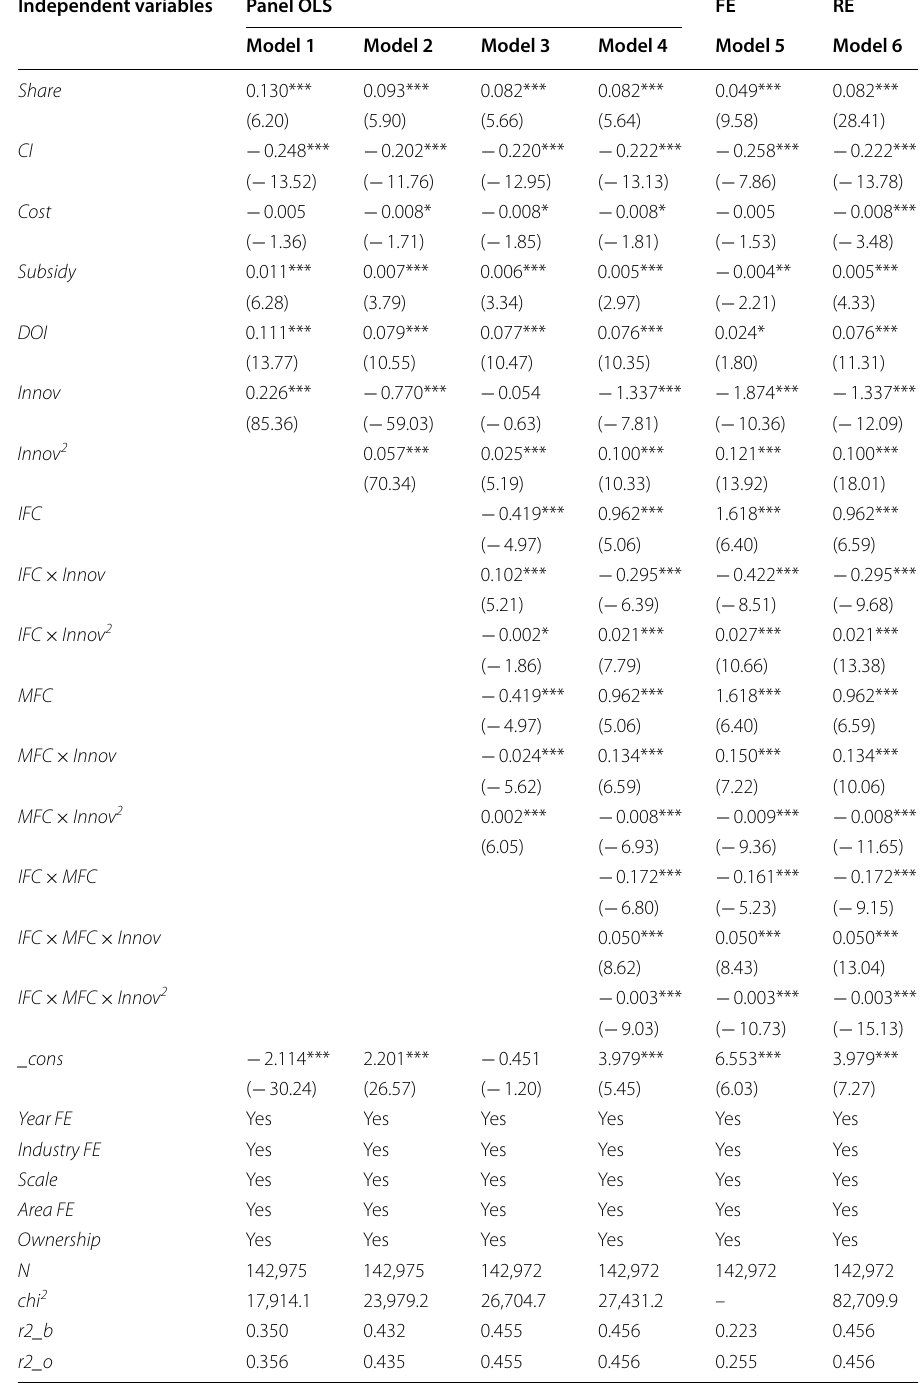
Table 3 Main hypotheses testing